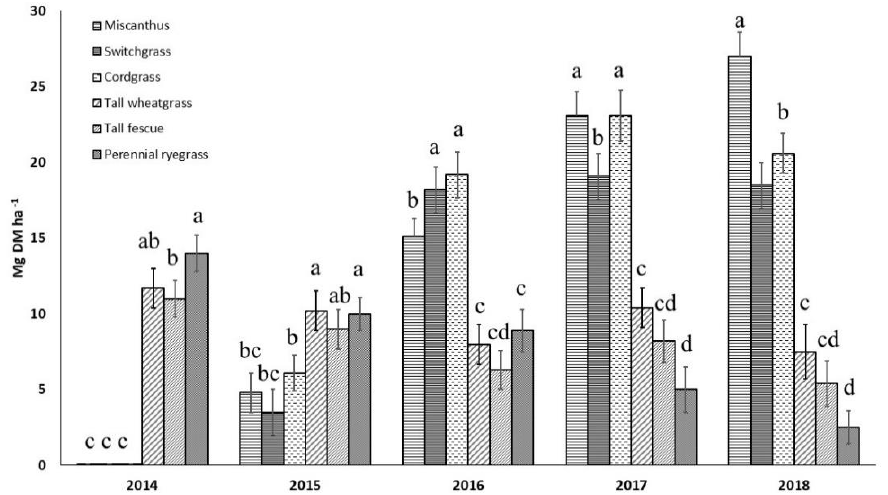
Figure 1. Biomass yields (in Mg DM ha − 1 ) of six perennial grasses from the year of establishment of plots. Vertical bars indicate standard deviations. Different letters indicate the presence of statistically significant differences at p < 0.05 according to one-way ANOVA and Tukey test.